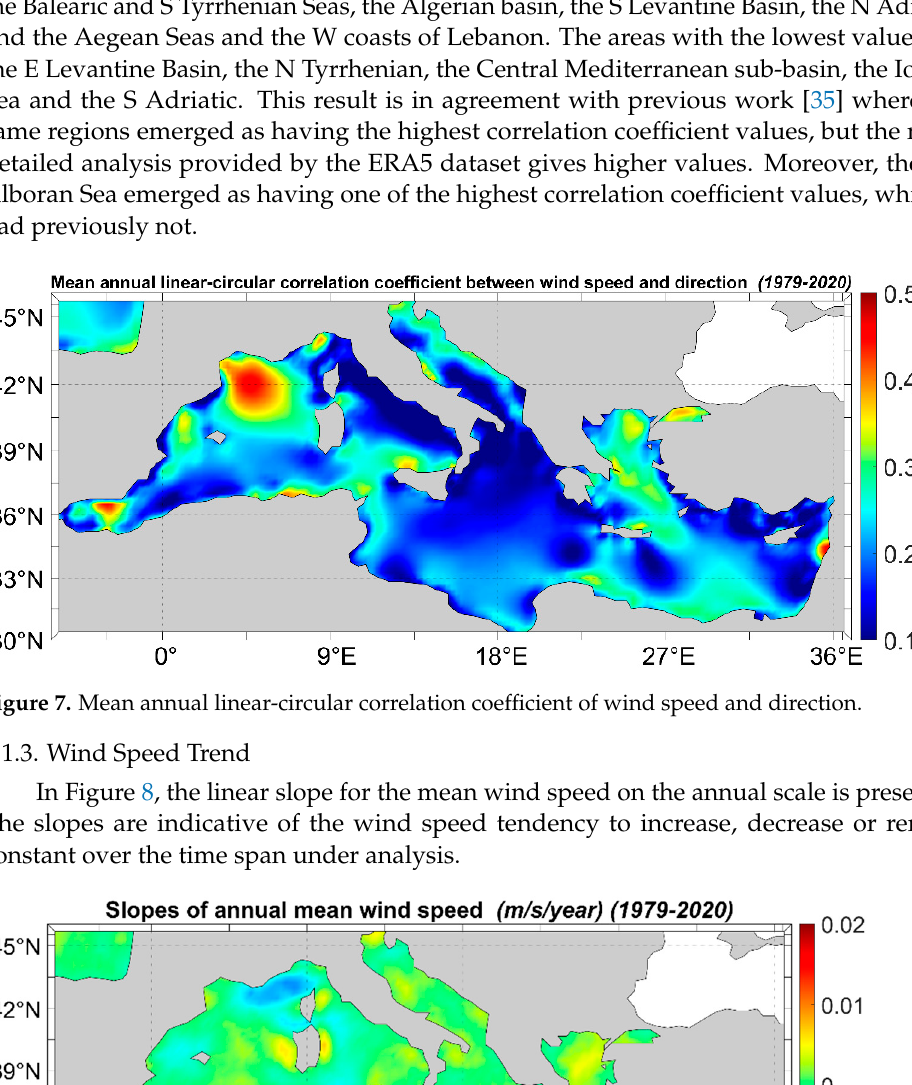
10 Figure 6. Angular distance between the decadal mean wind directions. The largest differences are observed for the decadal mean wind direction between the 3rd and 4th, as well as between the 1st and last decades. It is interesting to note that for some very particular regions positive and negative angular distances are simultane- ously present in the form of dipoles. These areas are the entire Balearic Sea, the Ligurian Sea (offshore the Gulf of Genoa), across the Algerian coasts and the southern coasts of Turkey. Note also that the areas exhibiting high values of angular variance are largely the same as the areas exhibiting the highest decadal angular distances.